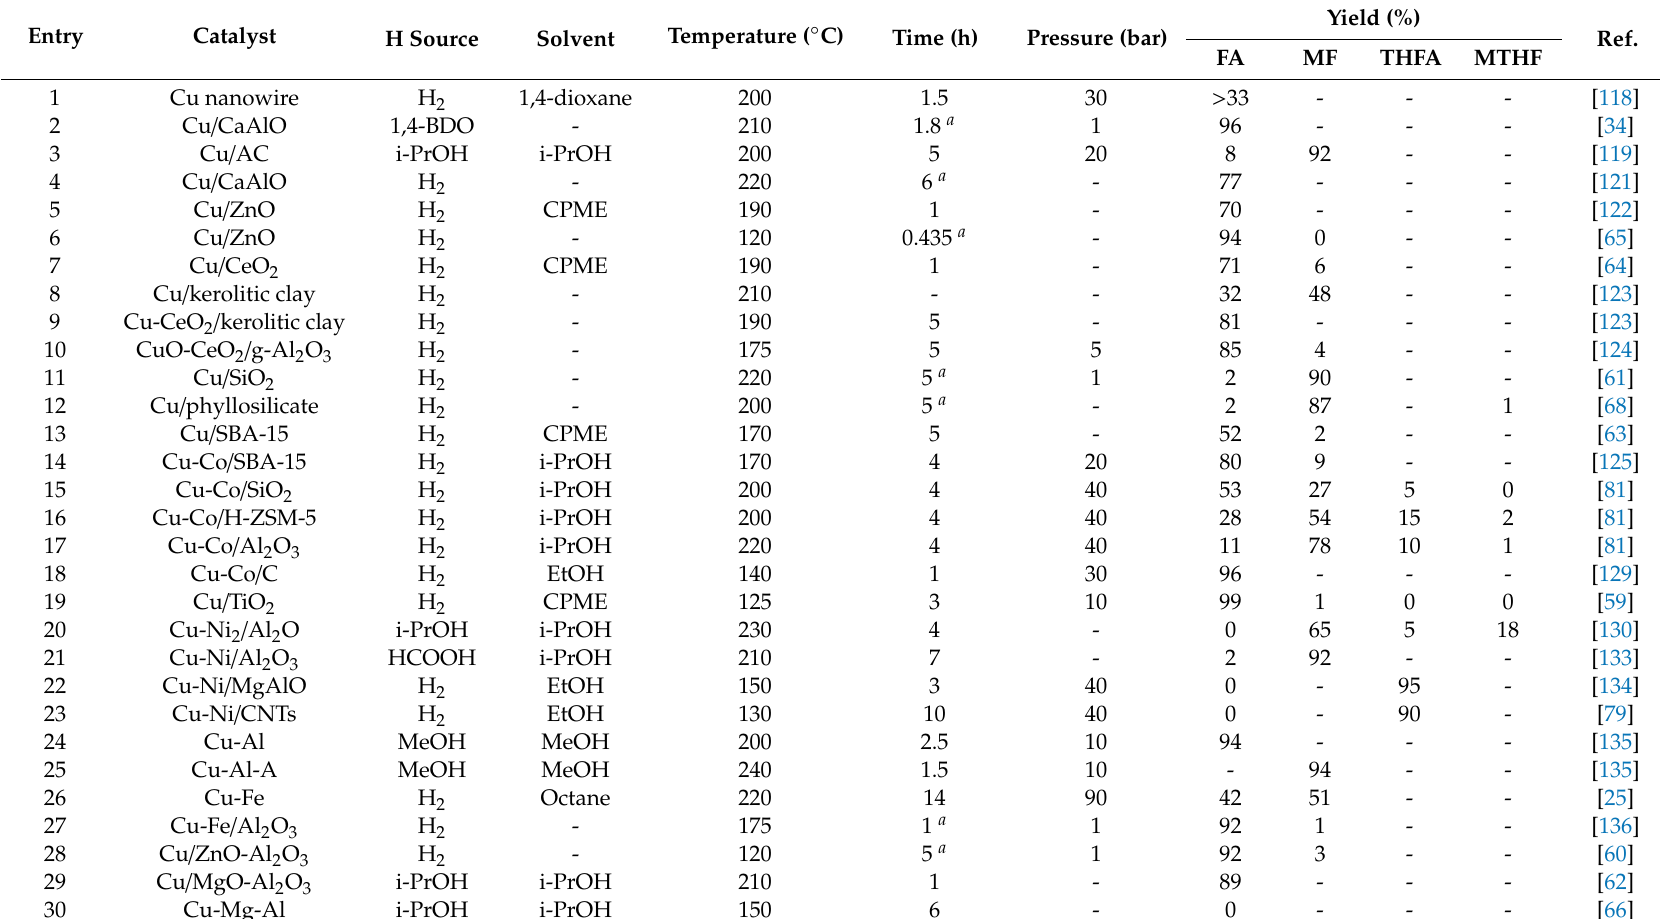
Table 1. Furfural hydrogenation over Cu-based